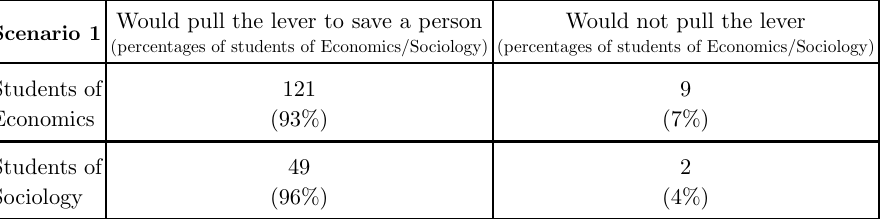
Results of Ill-informed Bystander , Bystander at the Switch , and Fat Man scenarios for students of Economics and